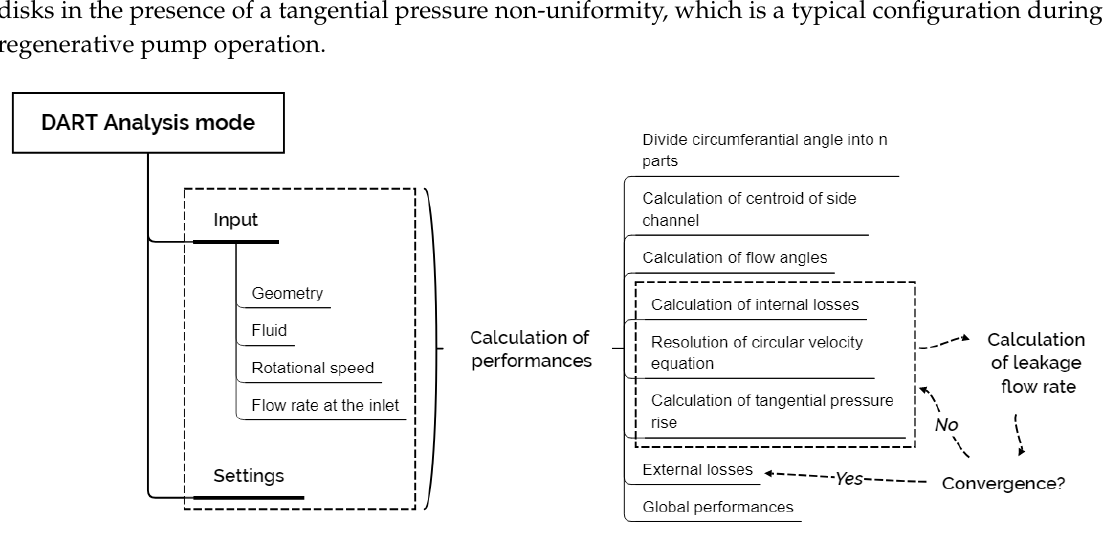
Figure 6. Scheme